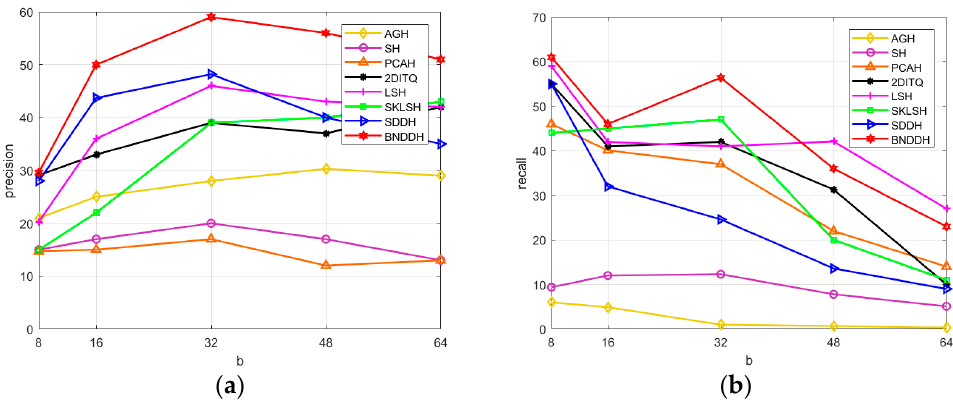
Figure 6. Precision and recall on the CIFAR-10 database ( a ) precision ( b ) recall. Table 2. MAP of different hash code lengths on the CIFAR-10 database.